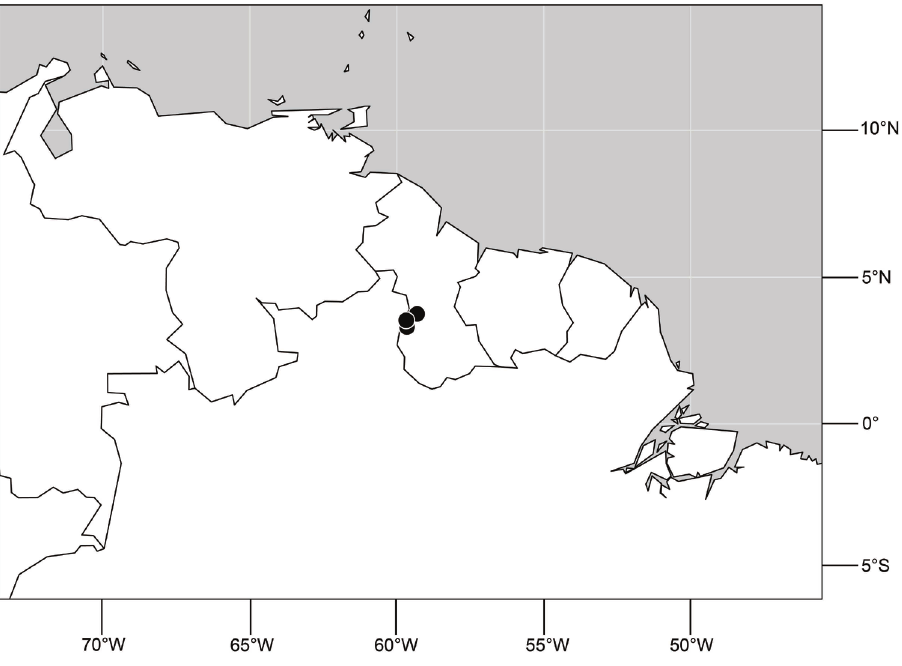
Figure 56. Distribution of Hydrochasma viridum sp.